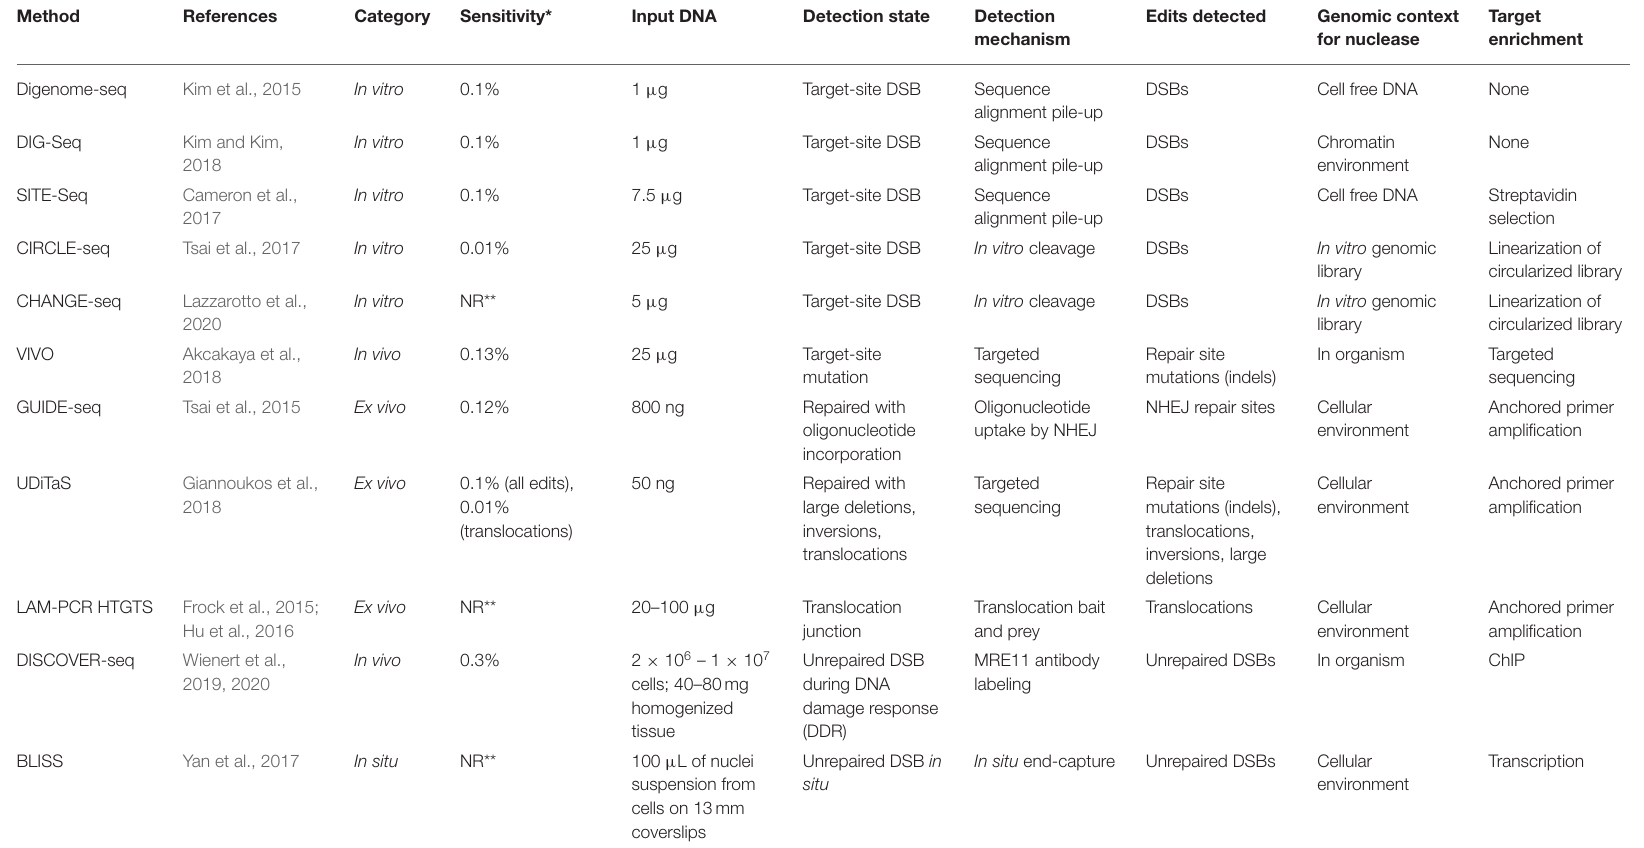
TABLE 2 | Important features that influence the utility of off-target detection